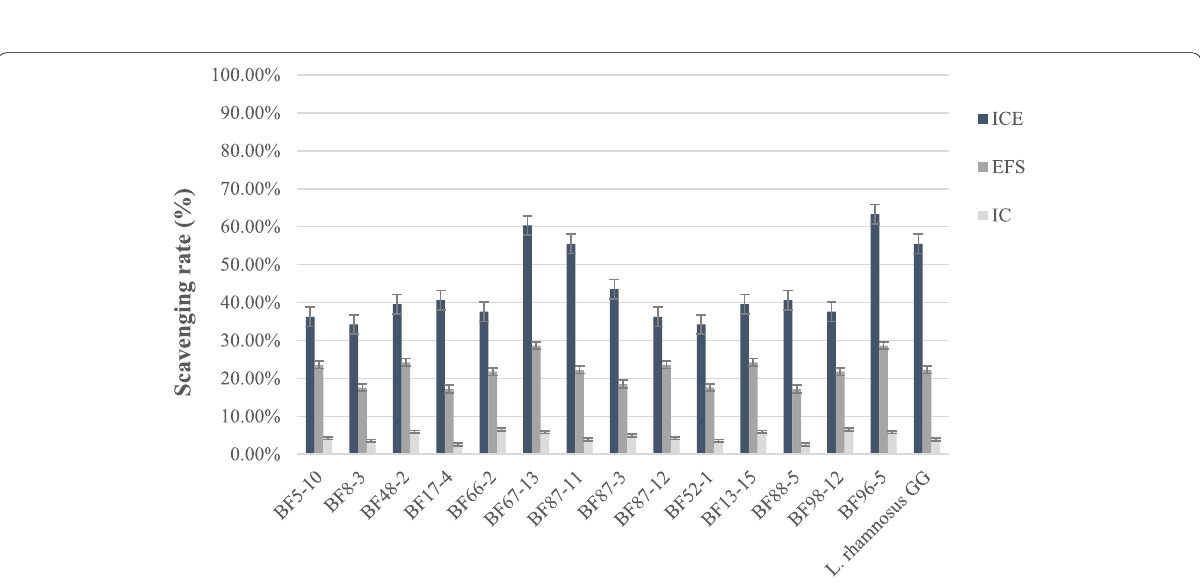
Fig. 6 The ability of the Bifidobacterium strains’ intracellular cell extract (ICE), extracellular fermentation supernatant (EFS), and intact cells (IC) to scavenge superoxide anion free radicals. (Error bars indicate standard deviation from three independent